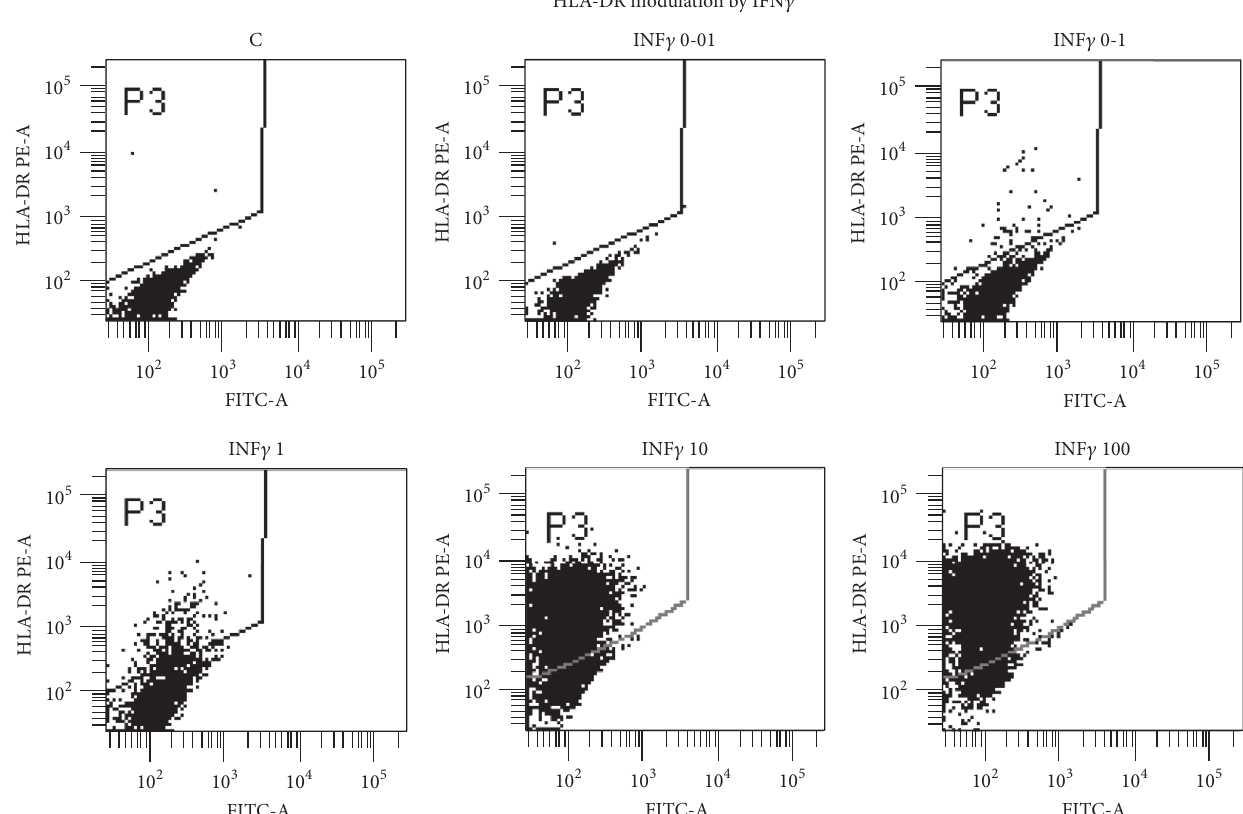
Figure 3: Dot plot analysis of C-MSCs treated with graded amount of IFN 𝛾 ng/ml for 72 h. Bowel MSCs were stained with PE-labeled HLA- DR mAB (Pharmingen) and analysed with FACSCanto